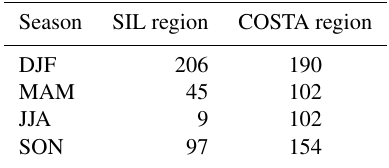
Table 1. Total number of days included in any of the flood events in Galicia throughout the period